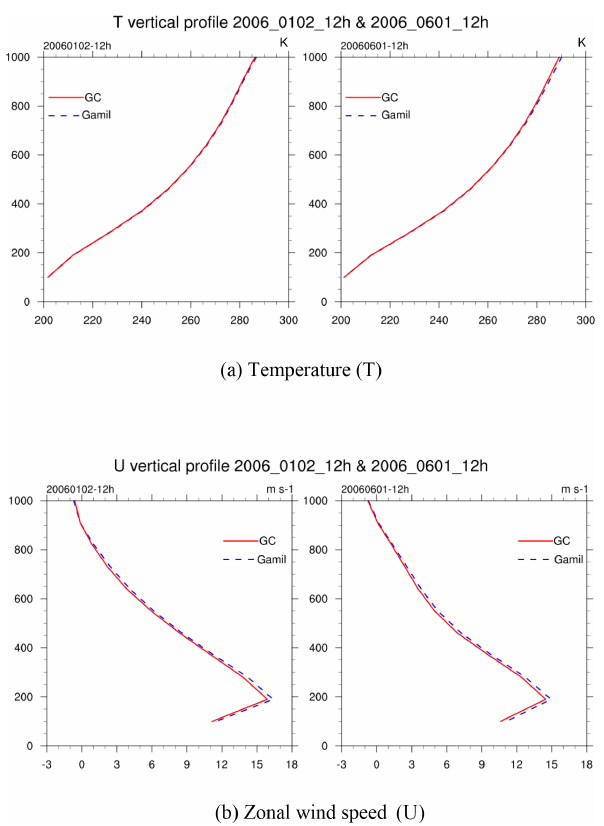
Figure 12. The global vertical profile of the temperature T (a) , and zonal wind speed U (b) , from GAMIL2 to GEOS-Chem (GC) at the 500hPa level at two different model times.